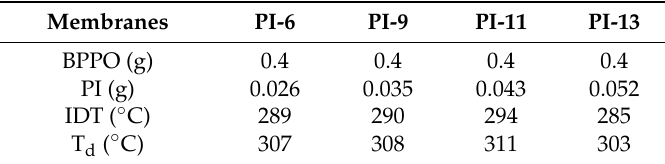
Table 1. Composition, initial decomposition temperature (IDT) and thermal decomposition temperature (T d ) of brominated poly-(2,6-dimethyl-1,4-phenyleneoxide) (BPPO) anion exchange membranes (AEMs) with increasing amounts of 2-phenylimidazole (PI).